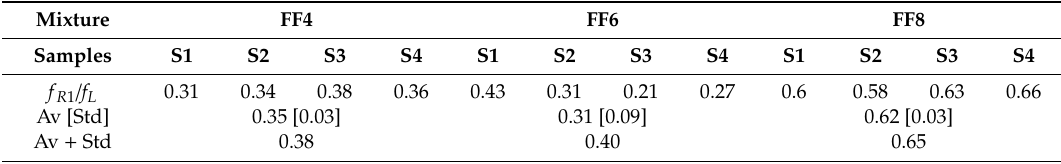
Figure 9. Simplified stress vs. CMOD model behavior for twisted-bundle macro-synthetic fiber reinforced self-compacting concrete (SCC). A trilinear constitutive model was adopted. Table 8. f R 1 / f L ratio of all tested samples for three di ff erent mixtures.